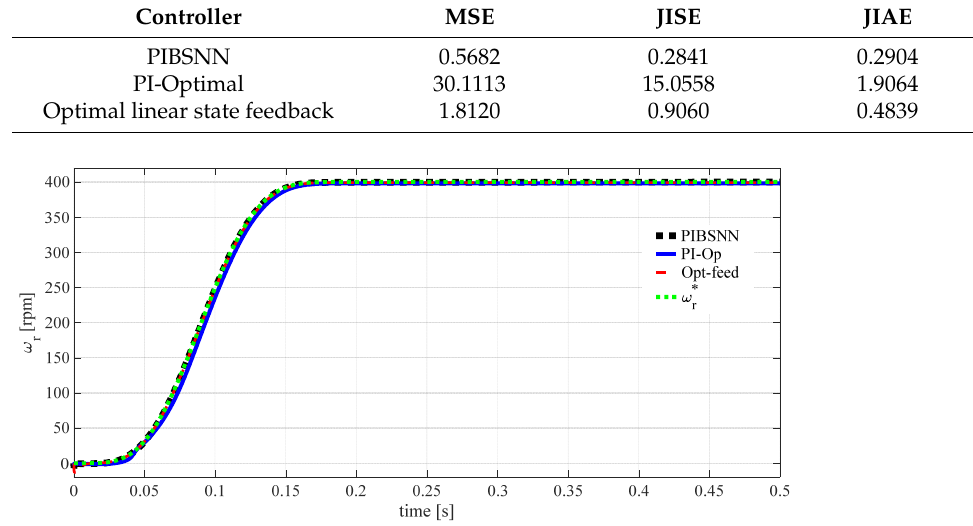
Figure 7. Tracking performance of PMSM drives with a crack in the rotor and unknown frictions.